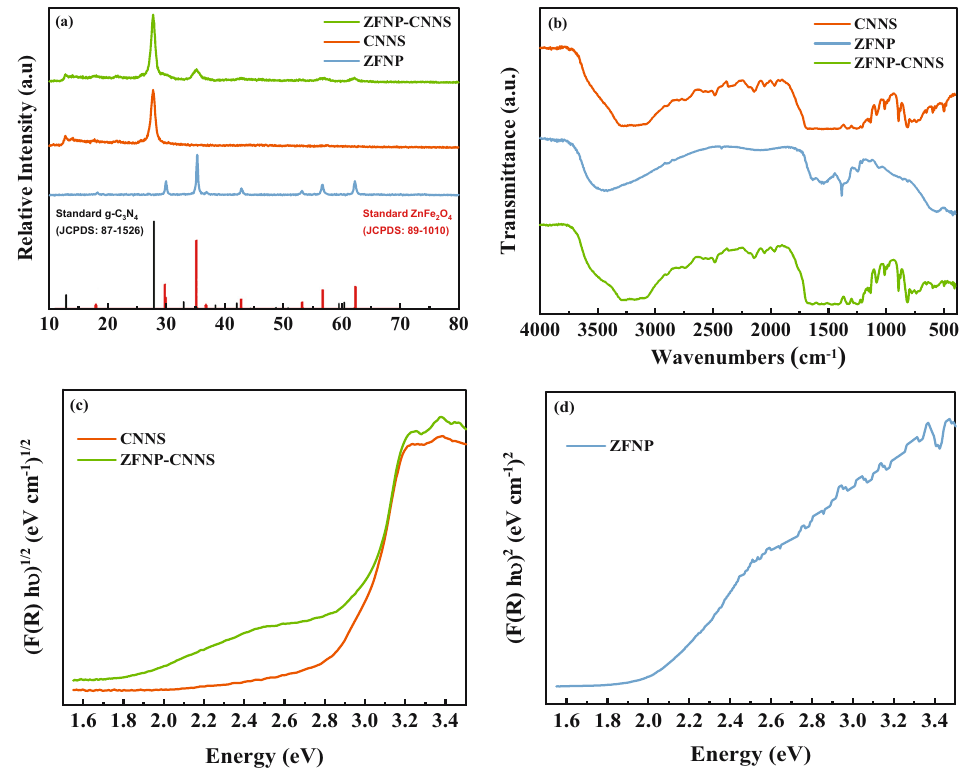
Figure 1: ( a ) XRD patterns, ( b ) FT - IR spectra, and ( c and d ) Kubelka – Munk extrapolation of CNNS, ZFNP, and ZFNP – CNNS